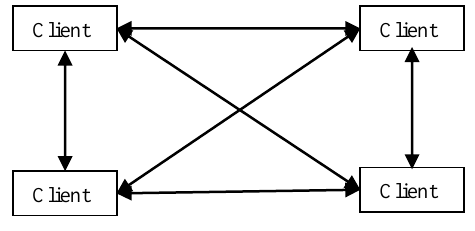
Figure 2. Peer to peer model